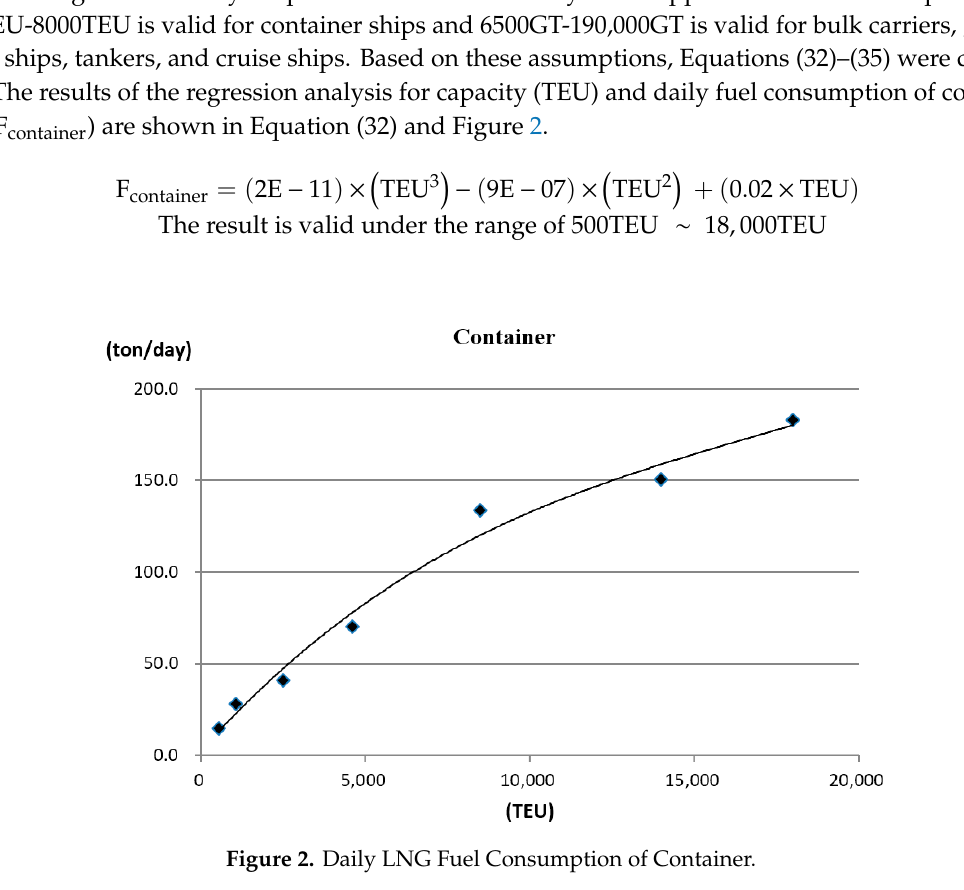
Figure 3. Daily LNG Fuel Consumption of Bulker and General Cargo. The regression results for the total tonnage of the tanker line and the fuel consumption per day ( F (cid:2930)(cid:2911)(cid:2924)(cid:2921)(cid:2915)(cid:2928) ) are shown in Equation 34 and Figure 4. F (cid:2930)(cid:2911)(cid:2924)(cid:2921)(cid:2915)(cid:2928) = ( −3E − 09) ⅹ ( GT (cid:2870) ) + ( 0.0016 ⅹ GT) + 2.4714